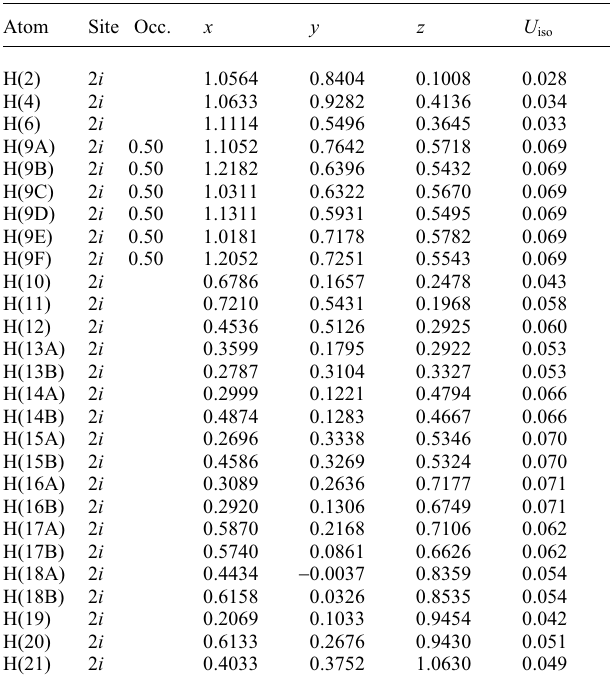
Table 2. Atomic coordinates and displacement parameters (in Å 2 )